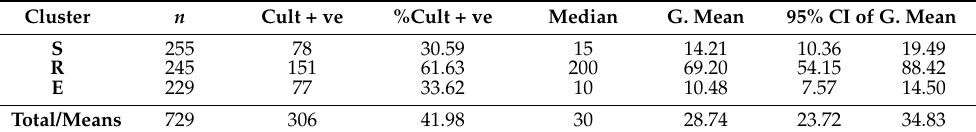
Table interpretation. n = no. of examined samples, Cluster S = soil and water sediments, Cluster R = peat and plant material, Cluster E = faeces and animals’ samples, Cult + ve = culture-positive, G. mean = geometric mean, CI = confidence